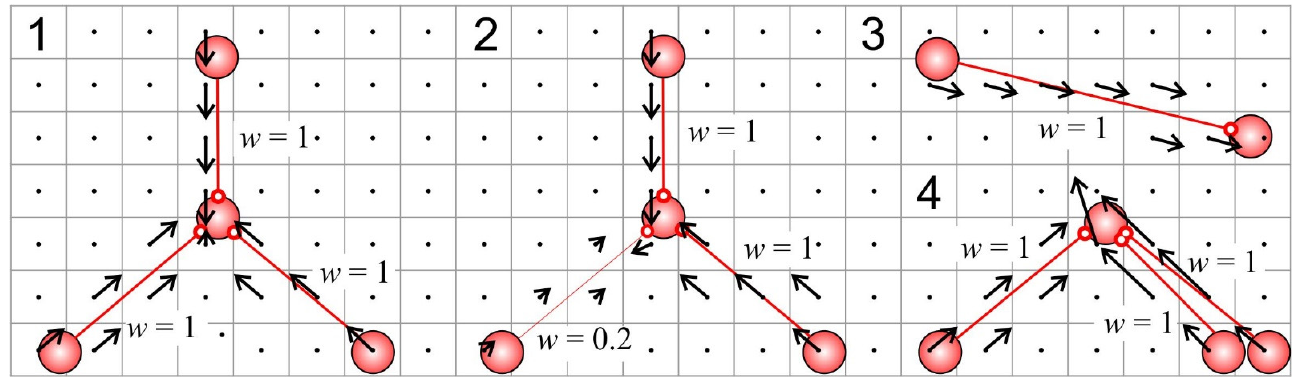
Figure 1. Examples of vector fields defined by synaptic connections in four small neural assemblies. Black arrows show the direction and magnitude of the synaptic vector field in a grid containing 7 × 23 cells (black points correspond to zero vectors). The thickness of the red links connecting neurons is proportional to the weight of interneuron couplings.